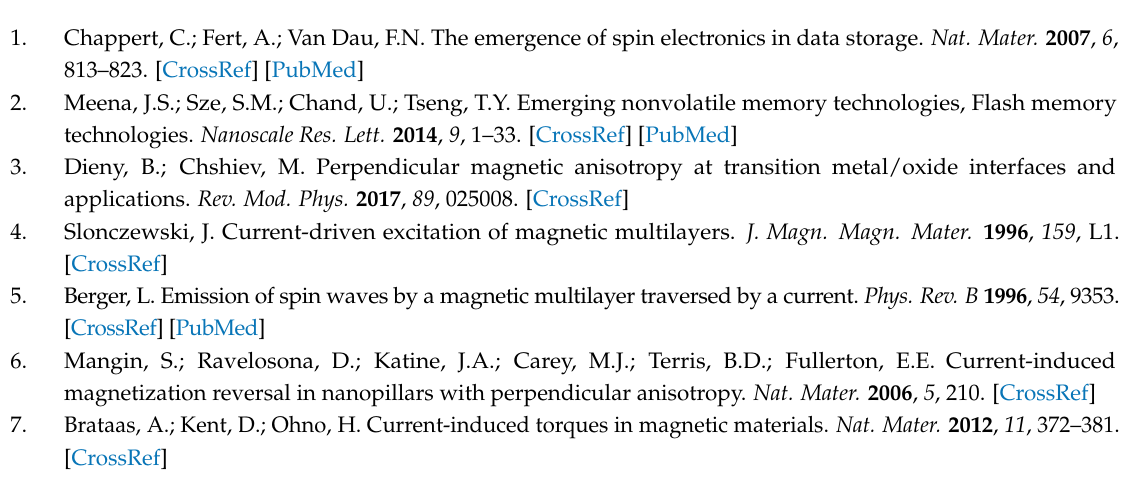
Figure A2. Atomic k-resolved MCAE for structure-II with η Fe = magnetization directions along [100] and [001]. The 1st, 2nd, and 3rd columns specify the bare data of no symmetrization, symmetrized component, and asymmetrized component,